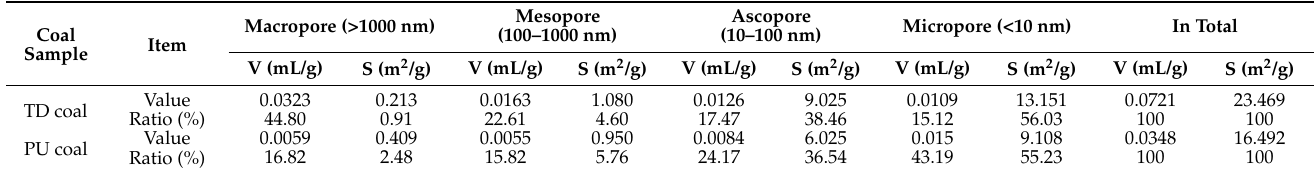
Table 1. Pore size distribution of coal